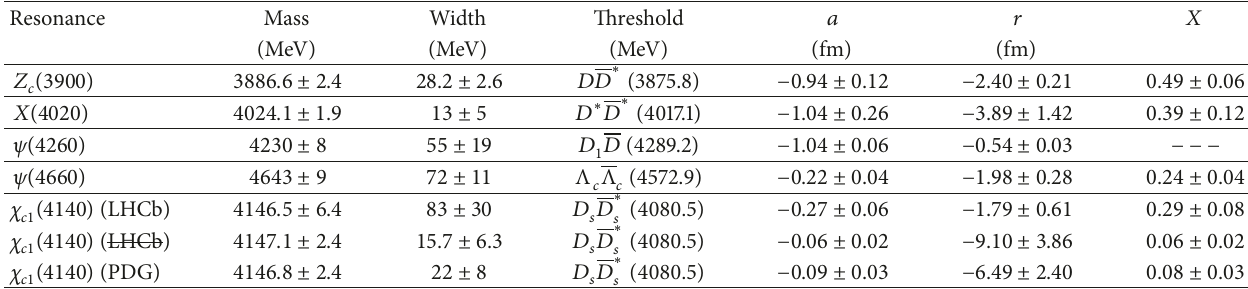
Table 1: In the second and third columns, the masses and widths of the 𝑍 𝑐 (3900) , 𝑋(4020) , 𝜓(4260) and 𝜓(4660) from the PDG are given. For the 𝜒 𝑐1 (4140) , we have distinguished three different determinations: LHCb, the average without LHCb (LHCb) and the PDG average. To make a conservative error estimate, the largest error bars are taken for the asymmetric ones in the values from the LHCb and PDG. We assume that the 𝑆 -wave two-particle states shown in the fourth column are responsible for the resonance poles. The corresponding thresholds are also explicitly given. The elastic scattering lengths, effective ranges, and the compositeness coefficients are provided in the last three columns. Since the mass of the 𝜓(4260) is below the 𝐷 1 𝐷 threshold, the probabilistic interpretation of 𝑋 does not hold in this situation [7].